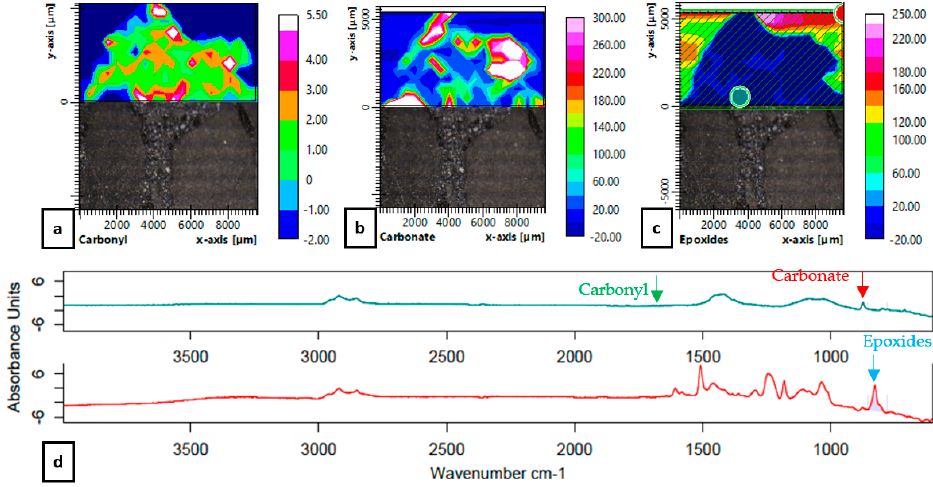
Figure 8. Chemical imaging of the GRA sample (Area 1): carbonyl group ( a ); carbonate group ( b ); epoxides ( c ); spectral visualization of the selected points marked by colored dots in Figure 8c ( d ).